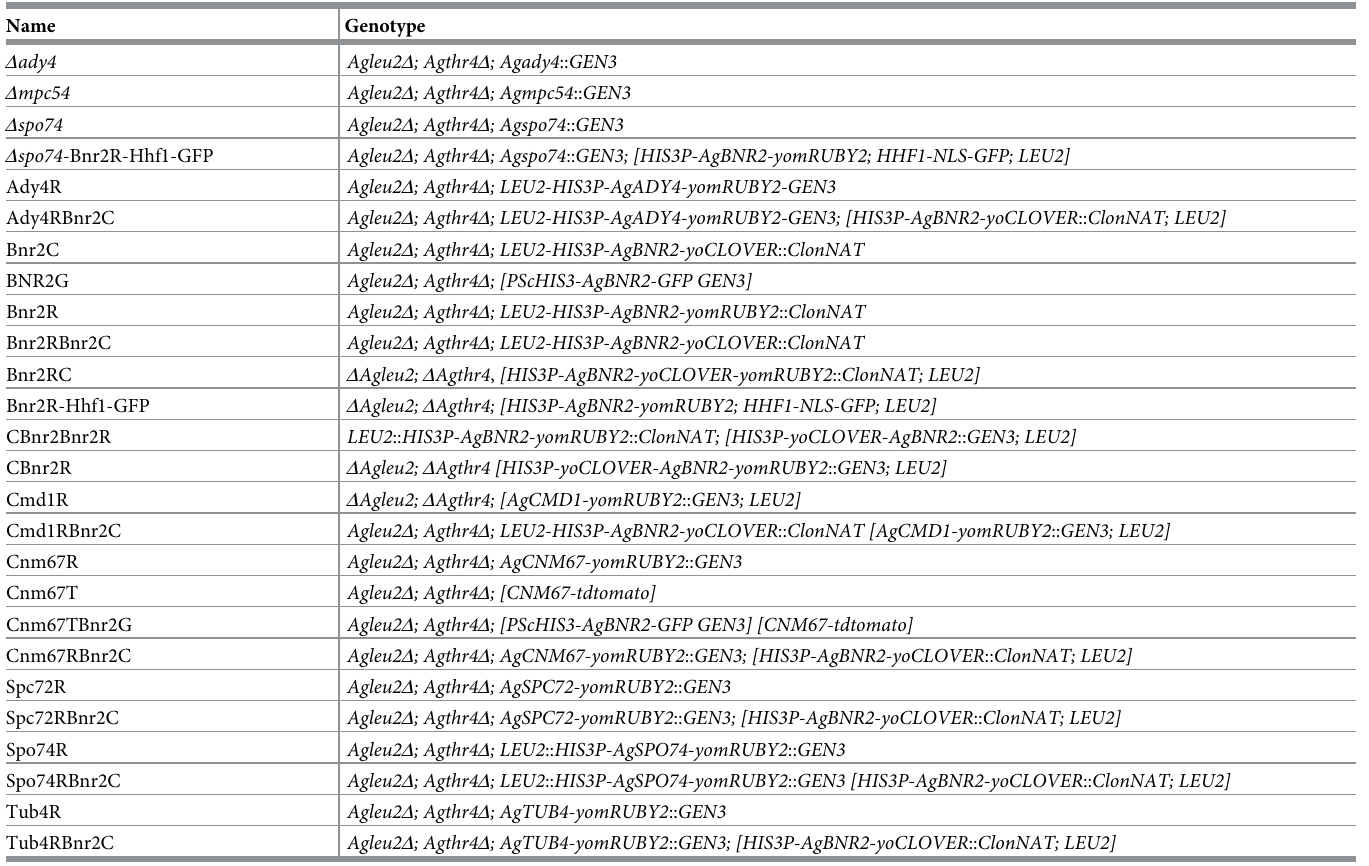
Table 1. Strain and genotypes used in this